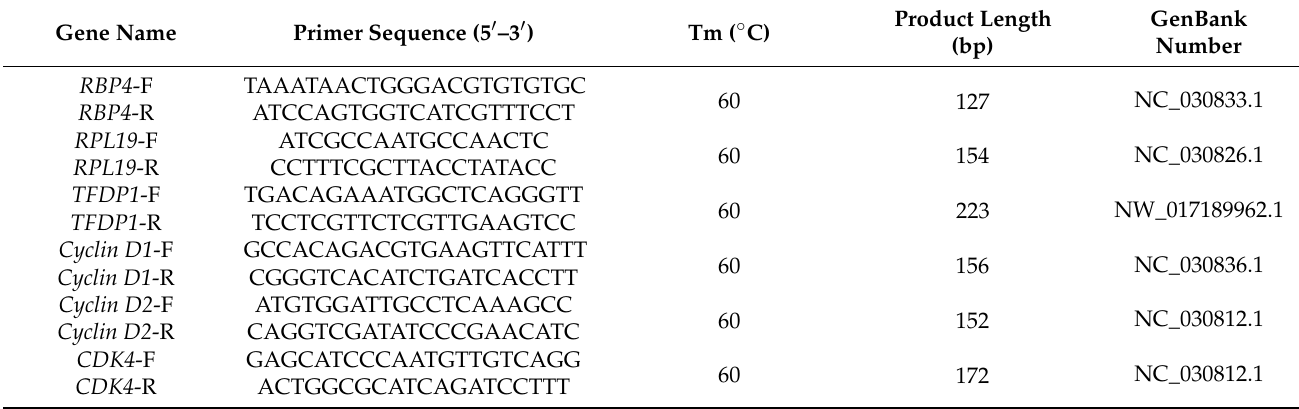
Table 3. Information on the primers used for